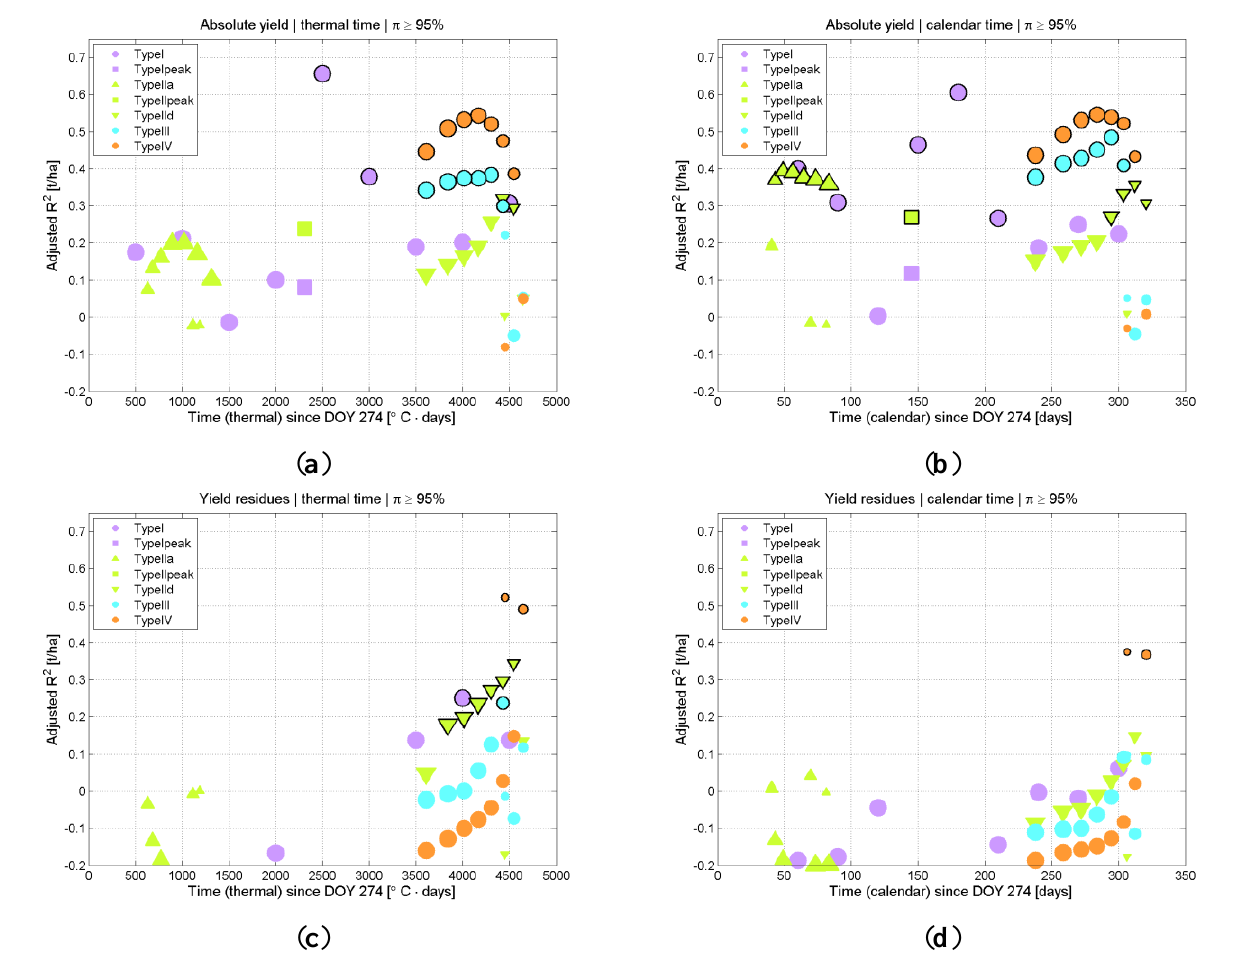
Figure 11. Predictive power, as indicated by the adjusted coefficient of determination (R 2 ), of individual metrics in estimating either absolute yield ( a , b ) or yield residues adj ( c , d ) plotted against the moment when these metrics become available during the growing season. Results are presented for an ensemble of time series with purity above 95% using either thermal (a,c) or calendar time (b,d). The markers representing the metrics that are significantly related ( p- value < 0.05) to the predicted variable have a dark bold edge. The size of the markers is directly related to the sample population of time series